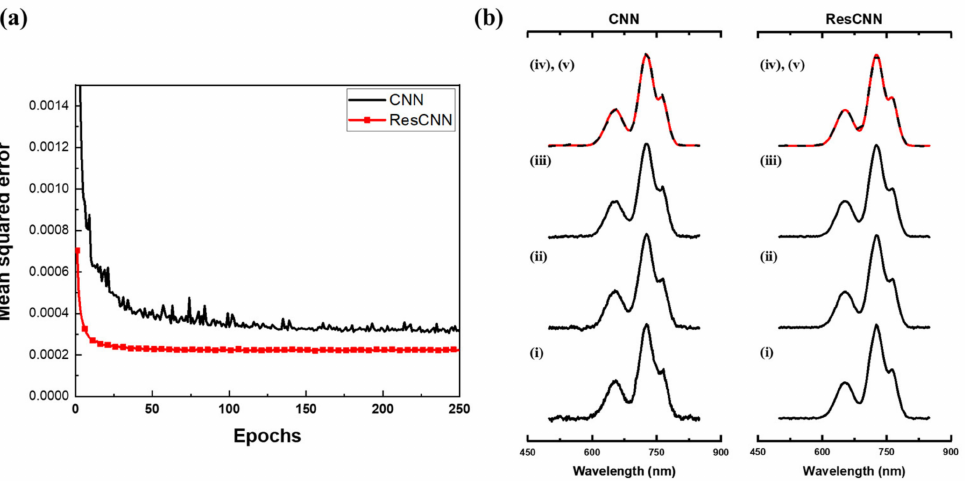
Figure 8. ( a ) Mean squared error of Gaussian dataset with respect to epochs. Solid black line denotes validation error of CNN, and solid red line with square symbols denotes validation error of ResCNN. ( b ) Reconstructions of a spectrum with respect to epochs where (i) to (iv) are epochs 1, 50, 150, and 250, respectively. Red line (v) denotes the original